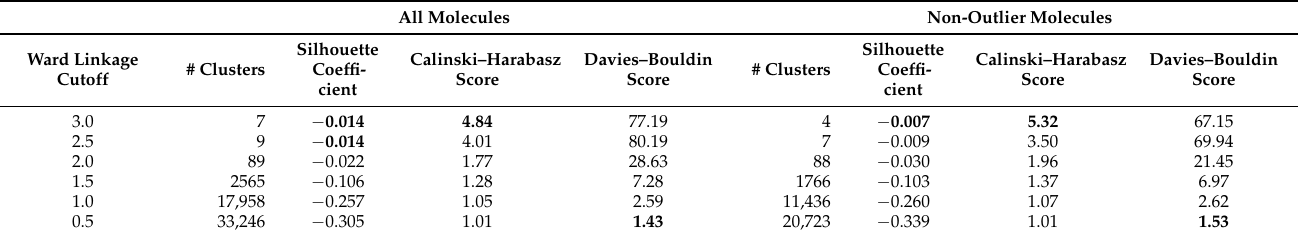
Table 2. Clustering quality depending on cutoff and outlier removal. Overall, an improvement in each of the clustering quality metrics is observed when outlier molecules are removed. Clustering quality metrics were calculated for each Ward linkage cutoff evaluated in hierarchical clustering. From top to bottom, each cutoff is stricter than the previous one. Here, 32,971 non-outlier molecules were retrieved at an outlier cutoff of 0.5. The best value for each metric for either all molecules or non-outlier molecules is highlighted in bold. For readability, clustering quality results were rounded to either two or three decimal